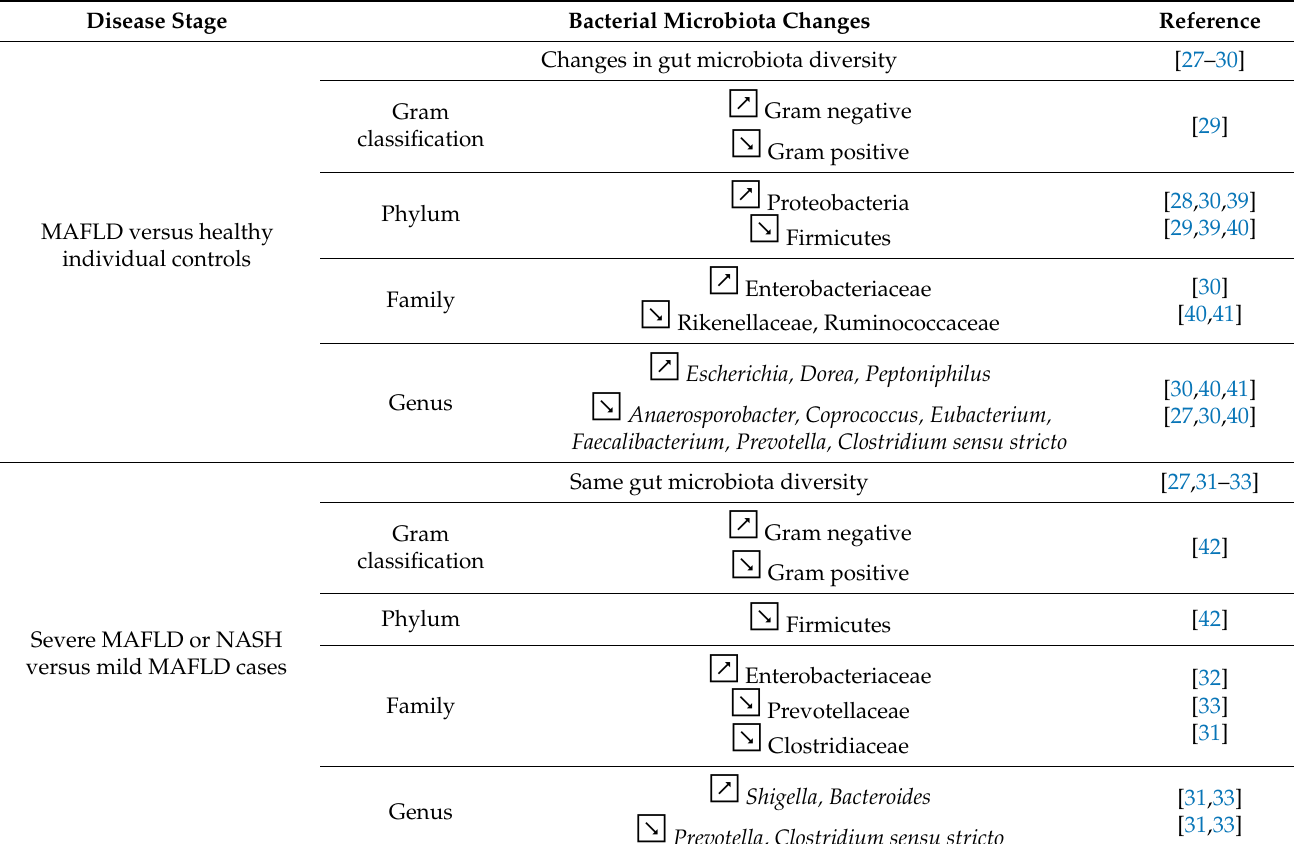
Table 1. Association of microbiota and metabolic dysfunction-associated fatty liver disease (MAFLD), non-alcoholic steatohepatitis (NASH) and NASH-related fibrosis.